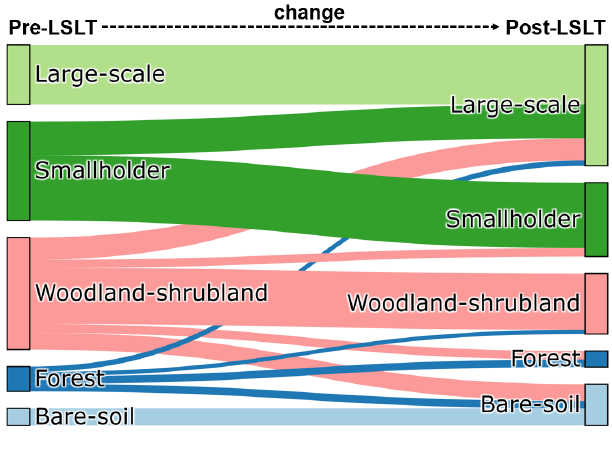
Fig. 3 . Direct land use and land cover (LULC) changes, i.e., within large-scale land transaction (LSLT) boundaries, aggregated over all eight sites. The widths of the bars indicate the fraction of each LULC type and transition. For clarity, transitions smaller than 5% of the largest transition are not